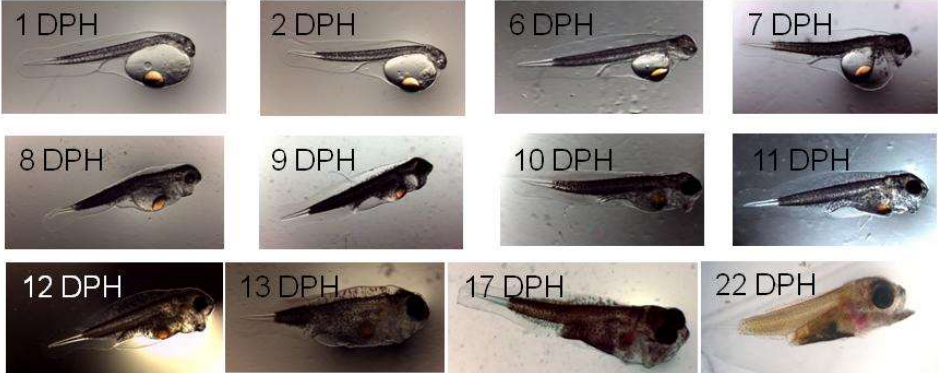
Figure 7. Images of wreckfish larvae from 1 dph to 22 dph reared at the IEO facilities.